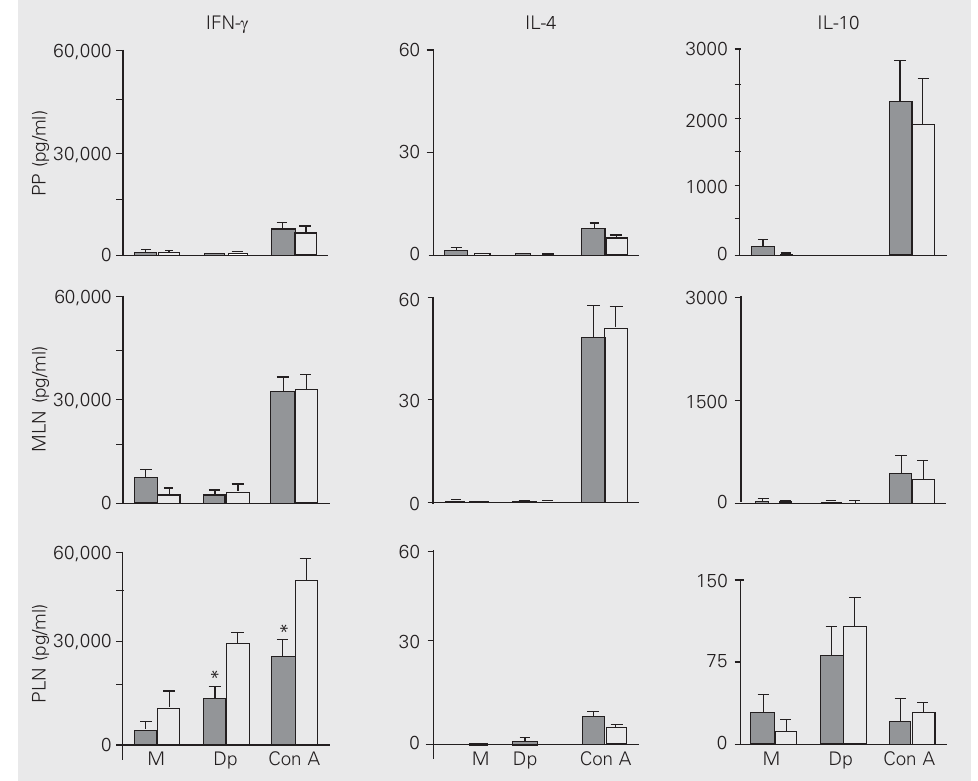
Figure 2. Profile of in vitro cy- tokine secretion by Peyer’s patch (PP), mesenteric lymph node (MLN), and peripheral lymph node (PLN) cells from previously sensitized mice fed a Dermatophagoides pteronyssi- nus (Dp) extract. Mice were fed either the Dp extract (closed bars) or saline (open bars) on the 6th, 7th and 8th days post- immunization (dpi). The PP, MLN and PLN cells were har- vested on the 12th dpi and cul- tured in the presence of Dp ex- tract (50 µg/ml), concanavalin A (Con A, µg/ml), or medium (M) alone (baseline level). Superna- tants obtained after 24 h were tested for interleukin (IL)-4, and supernatants obtained after 72 h were tested for interferon gamma (IFN- γ ) and IL-10. Data are reported as means ± SEM for 3 mice in each group of three individual experiments. *P < 0.05 compared to saline-fed mice (unpaired Student t